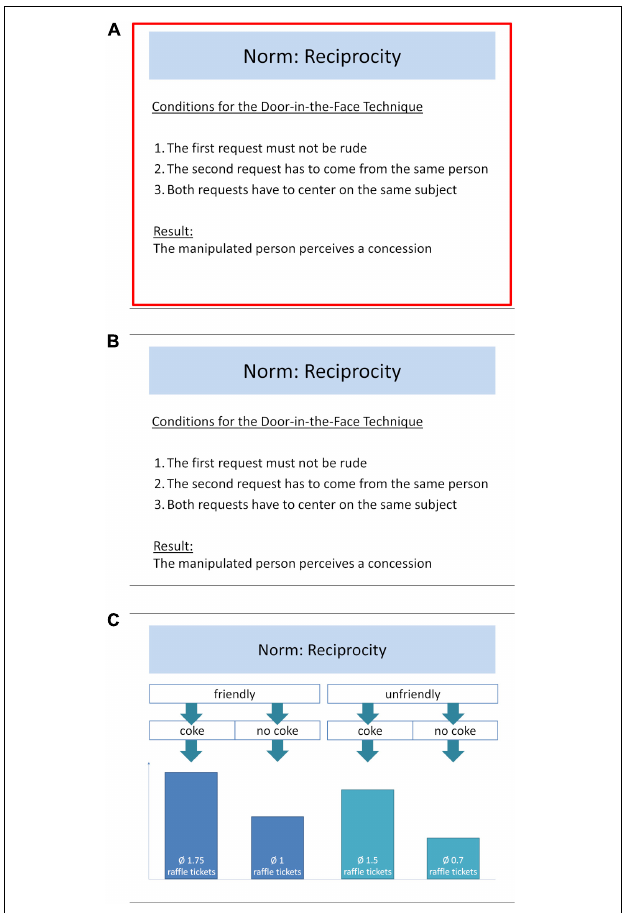
FIGURE 2 | Sample slides as used in the e-lecture during the initial study phase and during the learning phase of the note-taking conditions (translated from German). (A) Slide showing tested content as seen by the focused note-taking group (with a frame). (B) The same slide as seen by the note-taking group (without a frame). (C) Slide showing untested content as seen in the learning phase of both the note-taking and focused note-taking